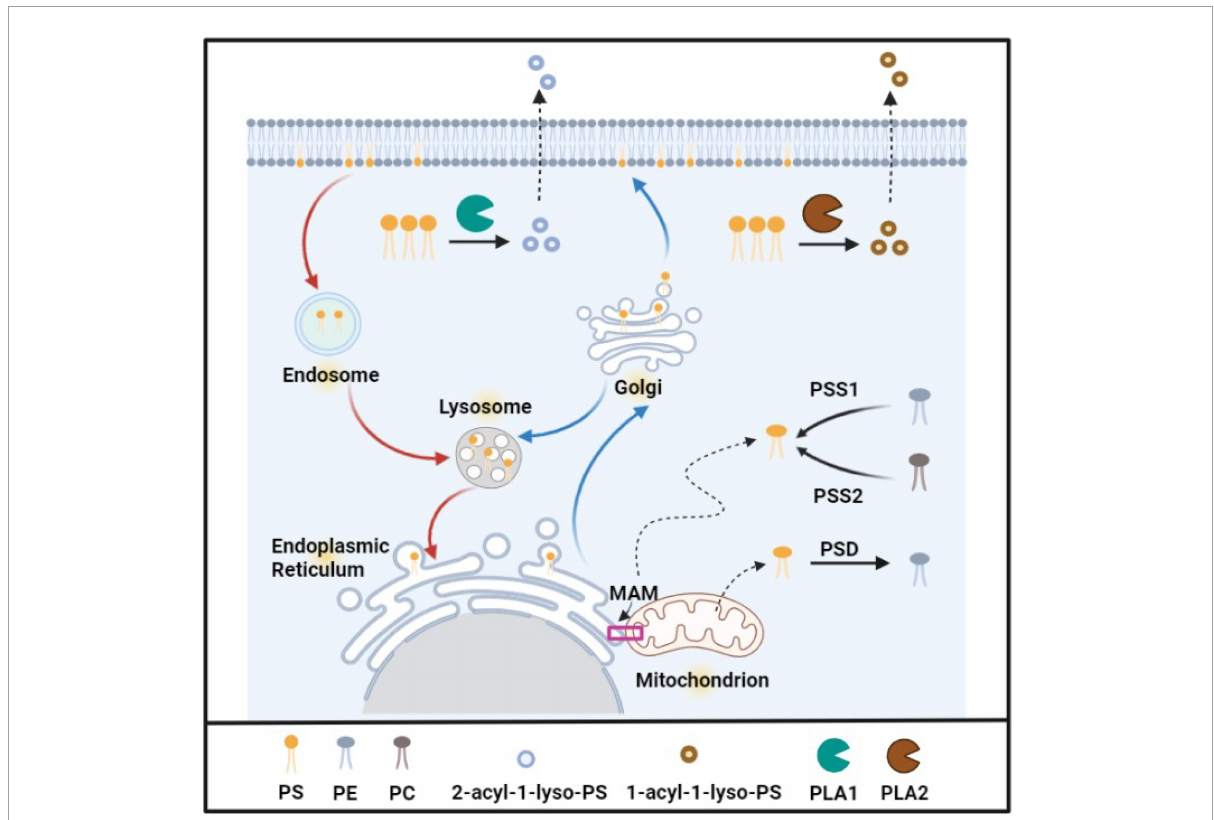
FIGURE1 The biosynthesis, distribution, and degradation of phosphatidylserine. PS is produced in ER (MAM), PSS1 catalyzes PE to PS, PSS2 catalyzes PC to PS. Some new PS is transported to mitochondria, and PS is decarboxylased and forms PE in mitochondria. PS is also transferred to the plasma membrane and other oranges by the Golgi via traditional vesicle-mediated trafficking. PS in the endosome is recycled to the plasma membrane. PS in lysosomes is derived from the Golgi apparatus or endosome. PS can be hydrolyzed by phospholipase A1 (PLA1) and phospholipase A2 (PLA2), the productions are 2-acyl-1-lyso -PS and 1-acyl-2-lyso-PS, respectively. Created with BioRender.com.